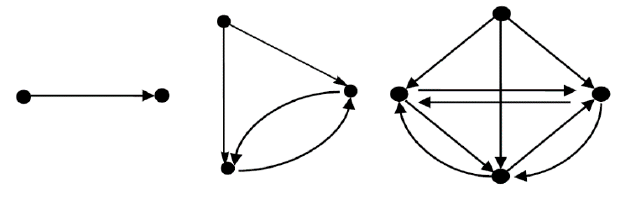
Figure 5. Examples of graphs.